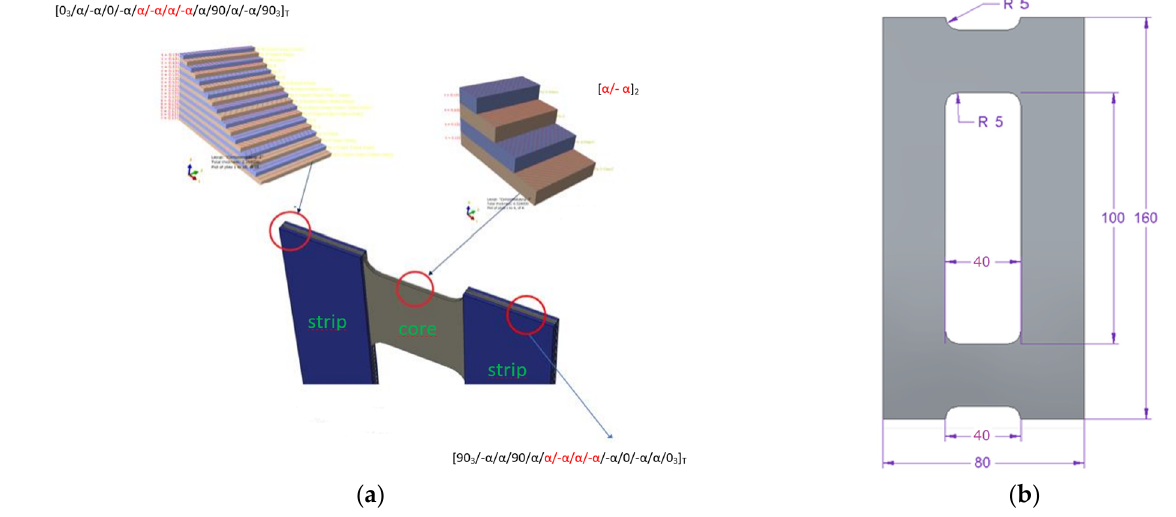
Figure 1. ( a ) Scheme of tested element for angle α = 45°; ( b ) scheme of specimen with the most important parameters.